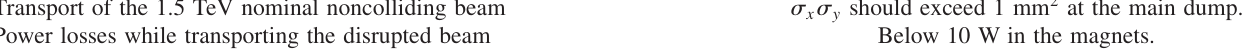
FIG. 7. Schematic layout of the CLIC post-collision TABLE II. Summary of the constraints used for the design of the CLIC post-collision line. Transport of the 1.5 TeV nominal noncolliding beam